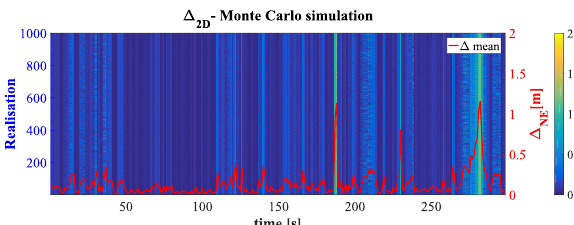
Figure 11. 2D Deviations of the estimated trajectory wrt reference. Vehicle 1 - Sensor setup 2